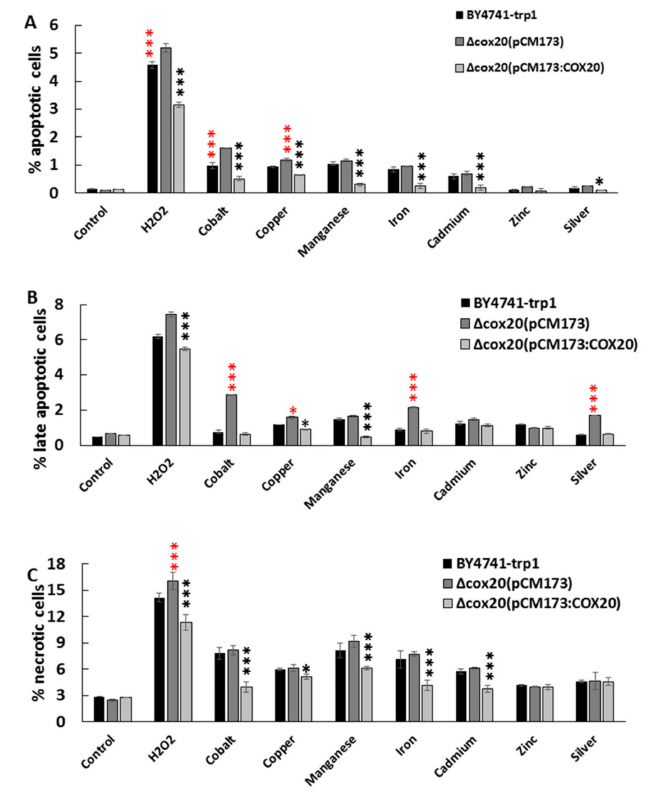
Figure 5. Detection of apoptosis and necrosis for BY4741-trp1, ∆ cox20(pCM173), and ∆ cox20 (pCM173:COX20) under control or oxidative stress conditions. ( A ) apoptotic cells in the presence of 1 mM hydrogen peroxide, 0.5 mM CoSO 4, CuSO 4 , MnSO 4 , FeSO 4 , CdSO 4 , ZnSO 4 , and AgSO 4 ( B ) late apoptotic cells in the presence of hydrogen peroxide, CoSO 4, CuSO 4 , MnSO 4 , FeSO 4 , CdSO 4 , ZnSO 4 , FeSO 4 , CdSO 4 , ZnSO 4 , and AgSO 4 respectively. Data show averages of triplicate assays with the BY4741-trp1 and BY4741-trp1 ∆ cox20 (pCM173:COX20), black asterisks indicate a significant di ff erence between BY4741-trp1 and BY4741-trp1 ∆ cox20